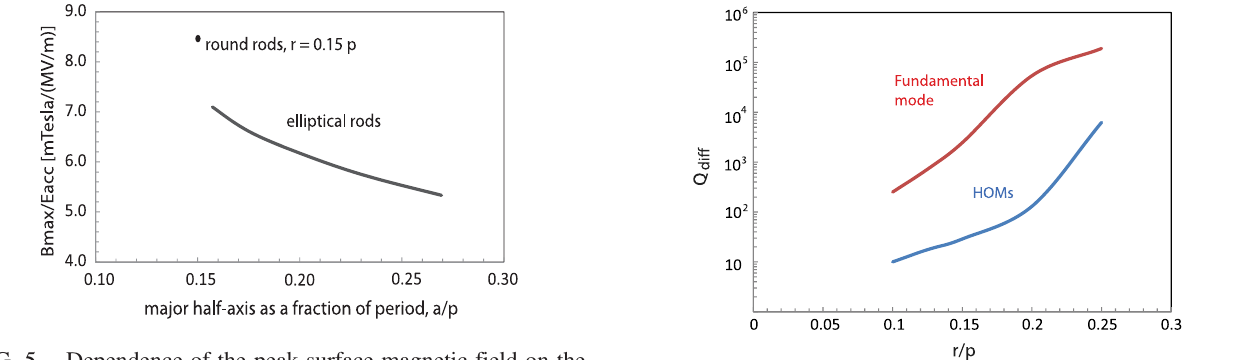
FIG. 7 (color online). A diffraction Q -factor for the funda- mental mode and the higher order modes in an open PBG resonator made of two rows of equally spaced round rods as simulated with the CST M ICROWAVE S TUDIO